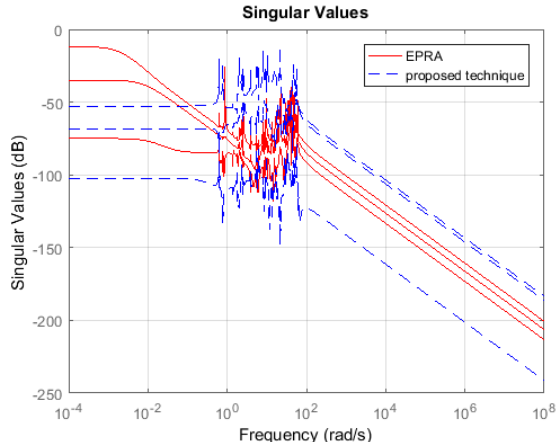
Figure 7. Sigma plot of the weighted error W ̅̅̅ 𝑜 (𝑠)[𝑃(𝑠) − 𝑃 𝑟 (𝑠)].